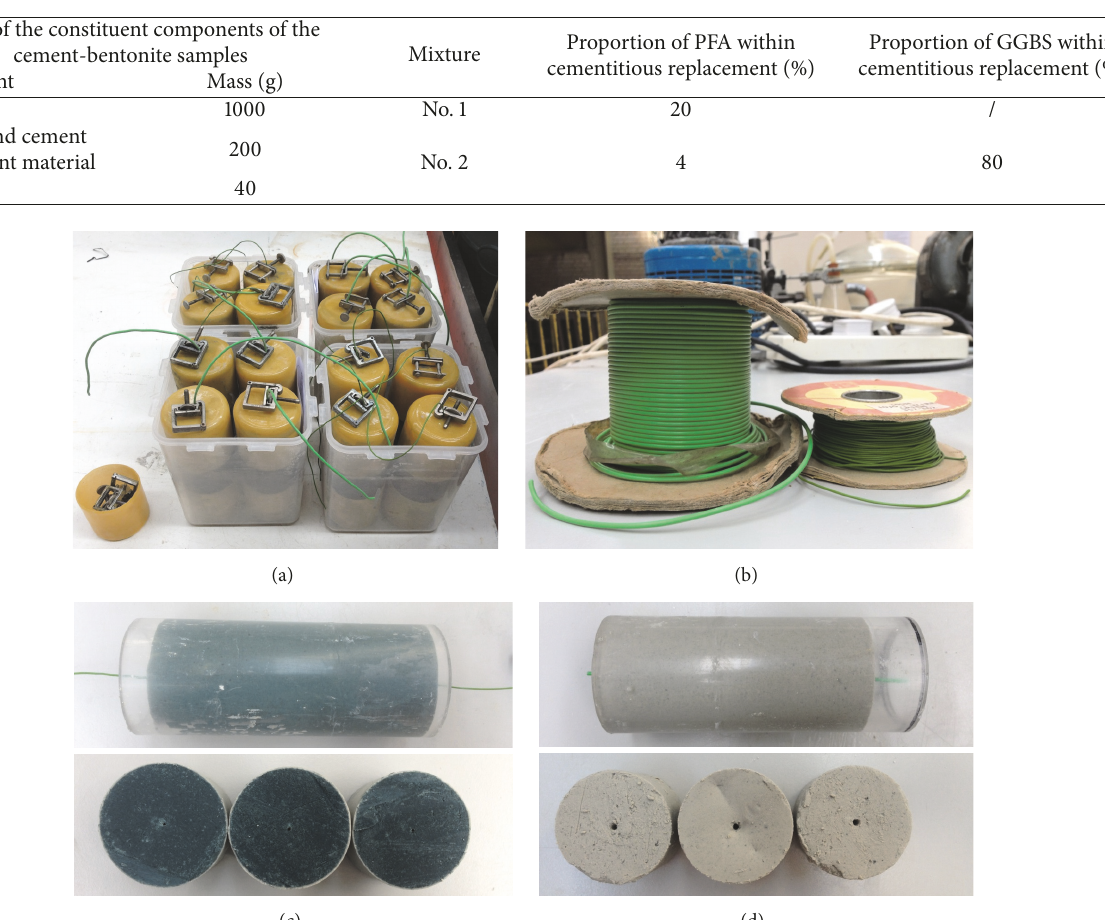
Table 1: Proportion of the constituent components within the two cement-bentonite mixtures.